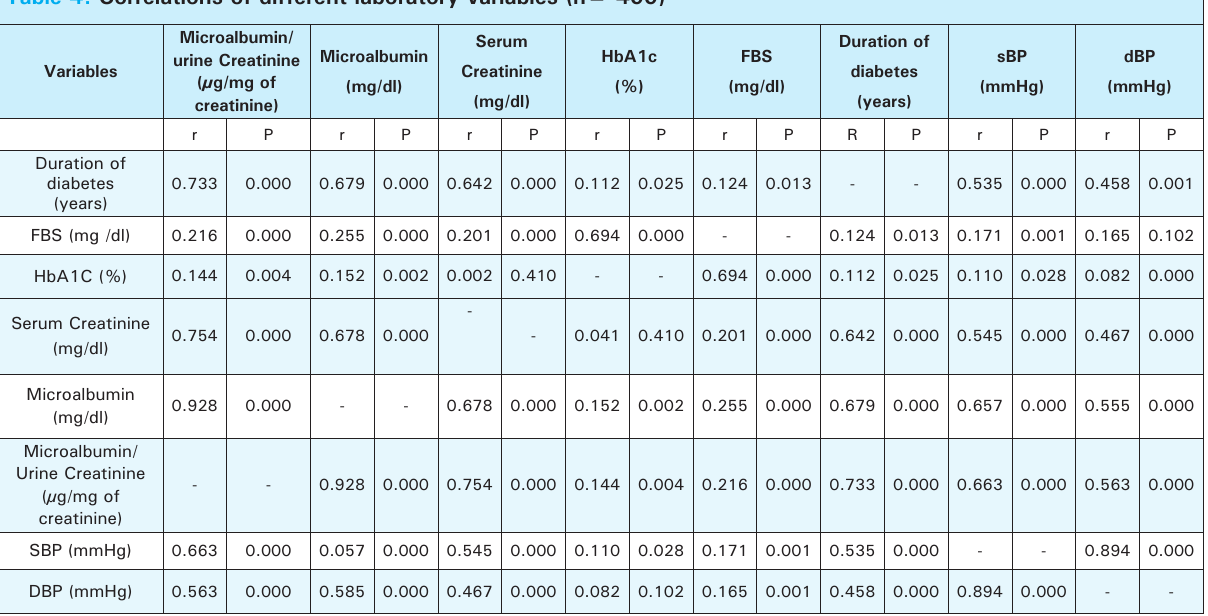
r: Pearsonian coefficient, P: significance at <0.05 (two tailed)